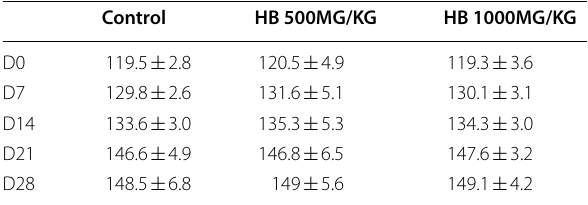
Table 5 Average weight of rats per week